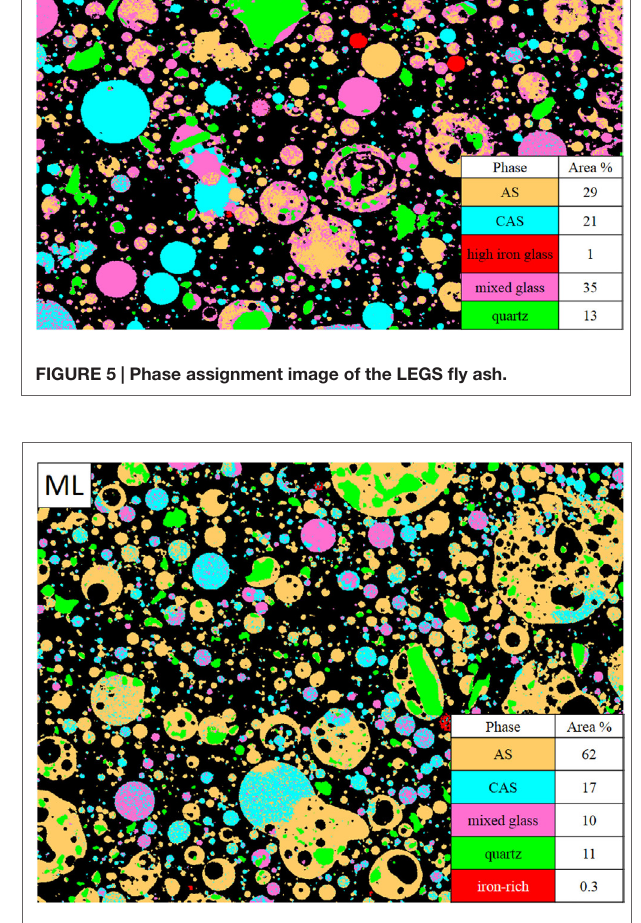
FigUre 6 | Phase assignment image for Ml fly